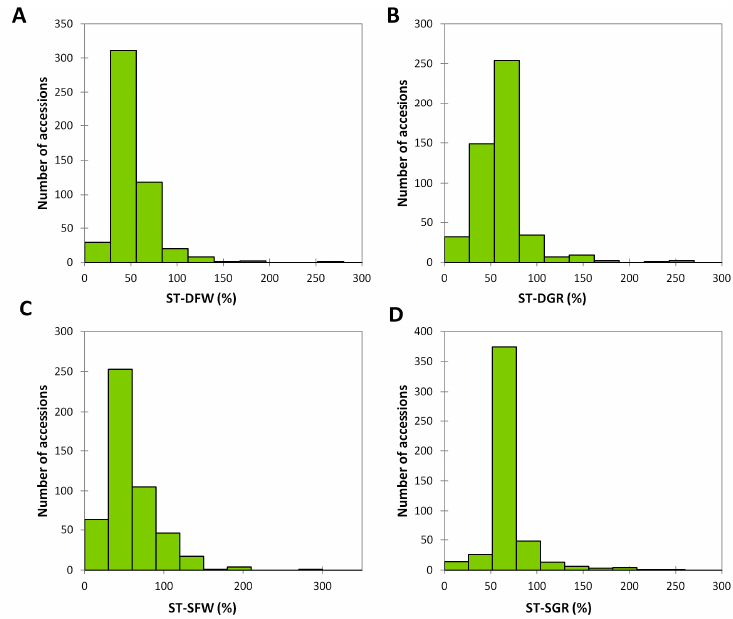
Figure 2. Phenotypic variation of the stress tolerance indexes for the measured traits. ( A ) Stress tolerance for fresh weight under PEG 6000 (ST-DFW) (%); ( B ) Stress tolerance for germination percentage under PEG 6000 (ST-DGR) (%); ( C ) Stress tolerance for fresh weight under salt (ST-SFW) (%); ( D ) Stress tolerance for germination percentage under salt (ST-SGR) (%).